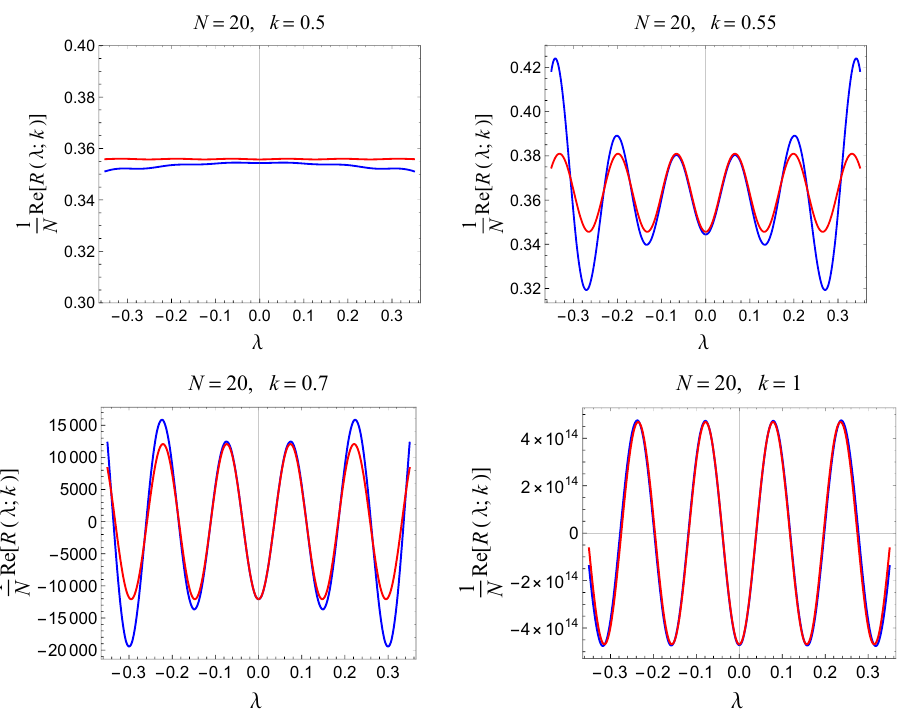
Figure 9 . Comparison of the real parts of the exact quenched density (3.16) (blue line) and its asymptotic approximation (3.34) (red